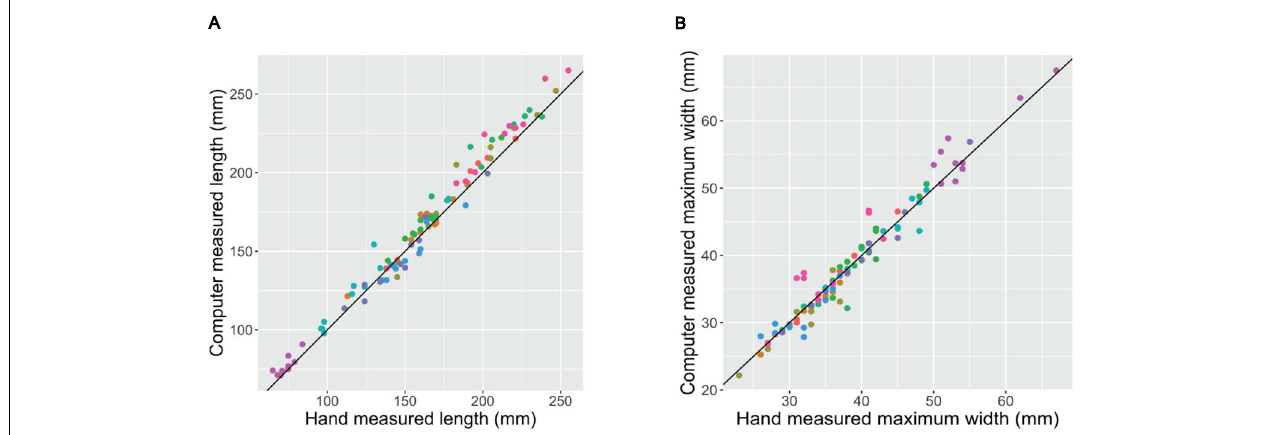
FIGURE 2 | Hand- ( x -axis) vs. digital image-based ( y -axis) measurements of length (A) and maximum width (B) of 100 carrot roots. Each point represents a unique carrot; colors indicate 1 of 10 carrot accessions representing a variety of market classes. RMSE of the linear model y = x was 8.30 mm for length and 2.00 mm for maximum